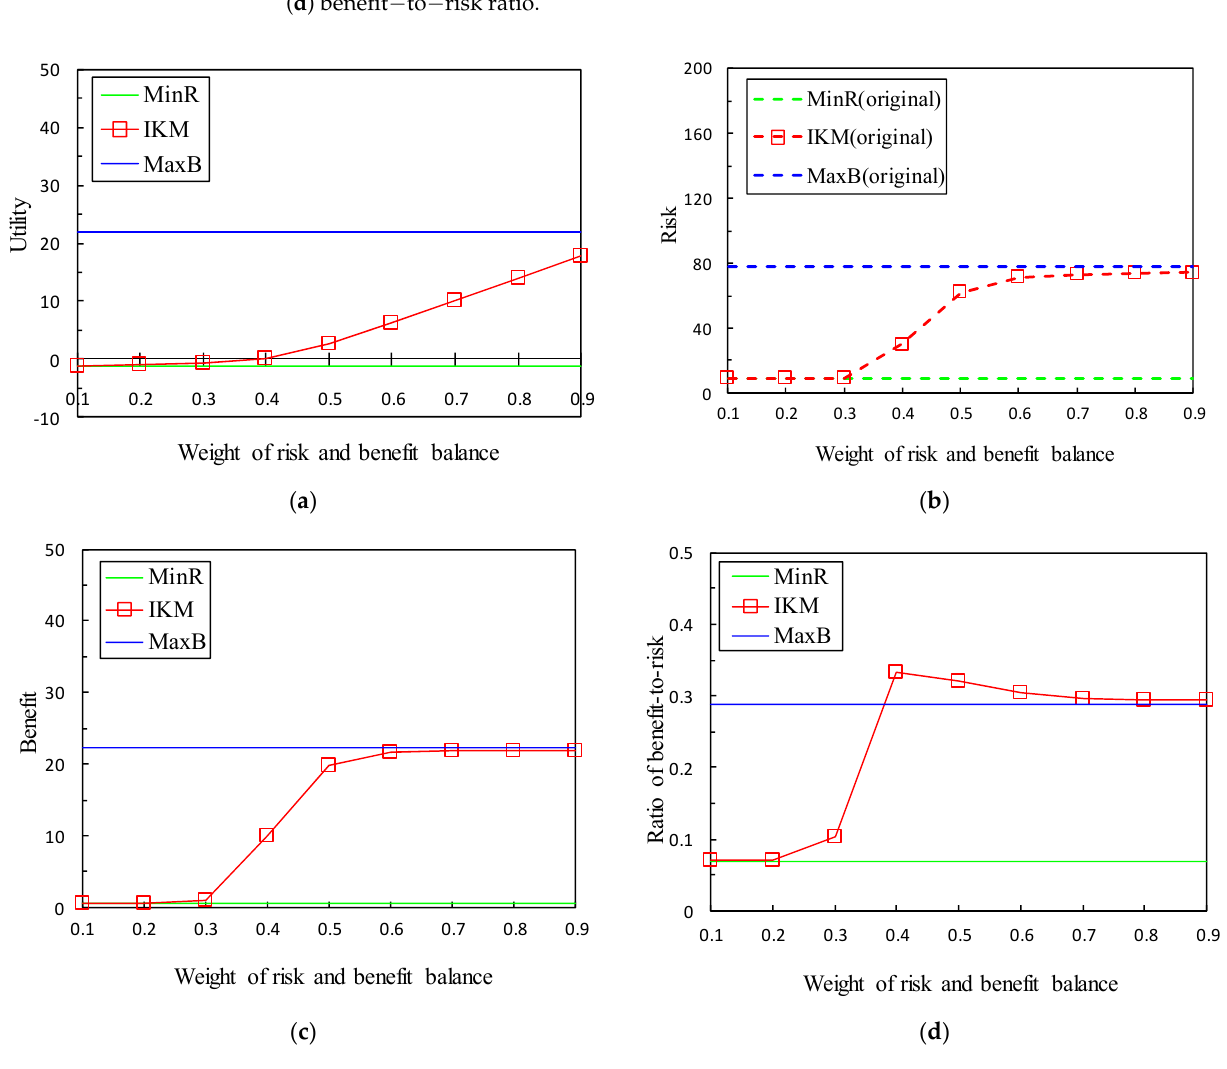
Figure 11. Effectiveness vs. weight of risk and benefit balance (Set #1.6). ( a ) Utility; ( b ) risk; ( c ) benefit; ( d ) benefit − to − risk ratio.